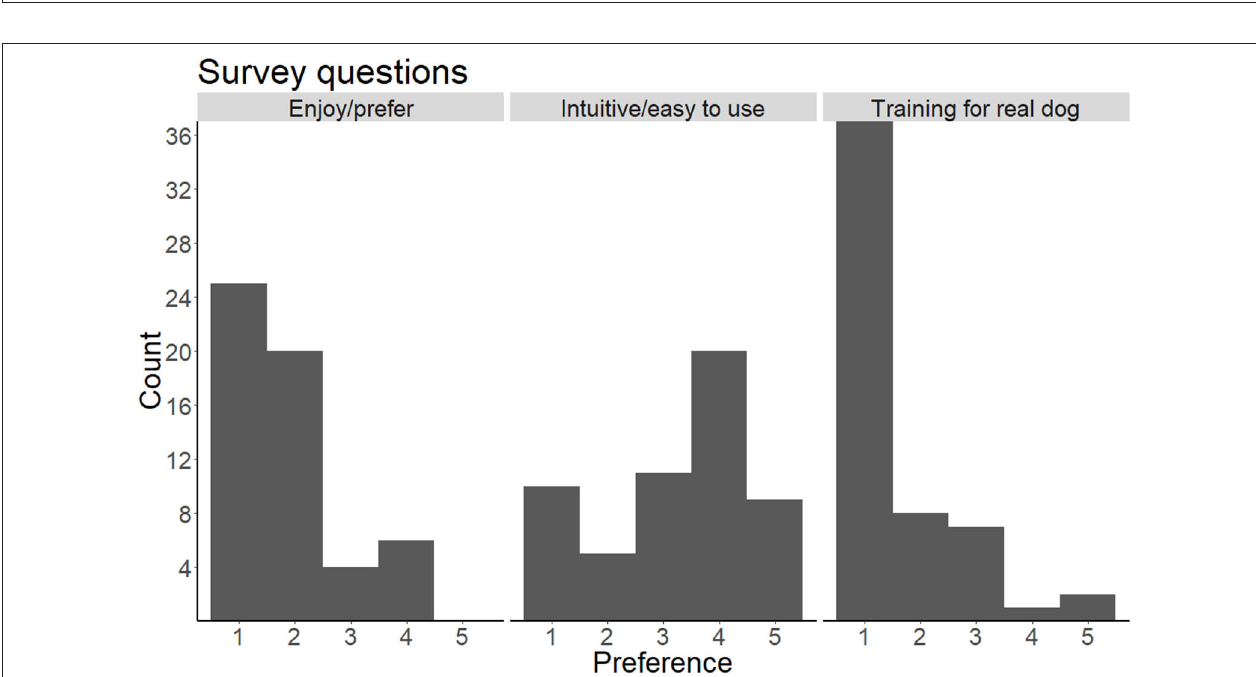
FIGURE 6 | Comparison of number of incorrectly reported symptoms. Error bars are the 95% confidence intervals.